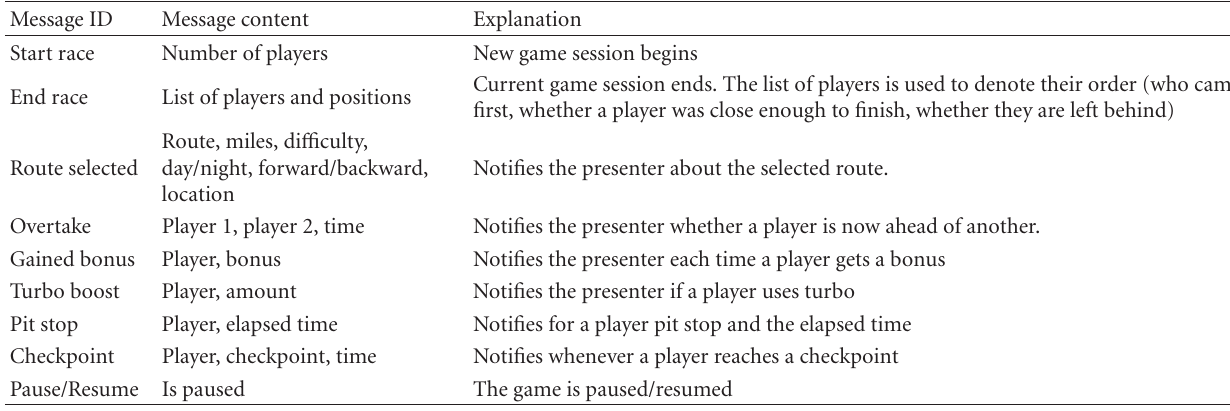
Table 4: A sample of common messages of the communication protocol (API) for race